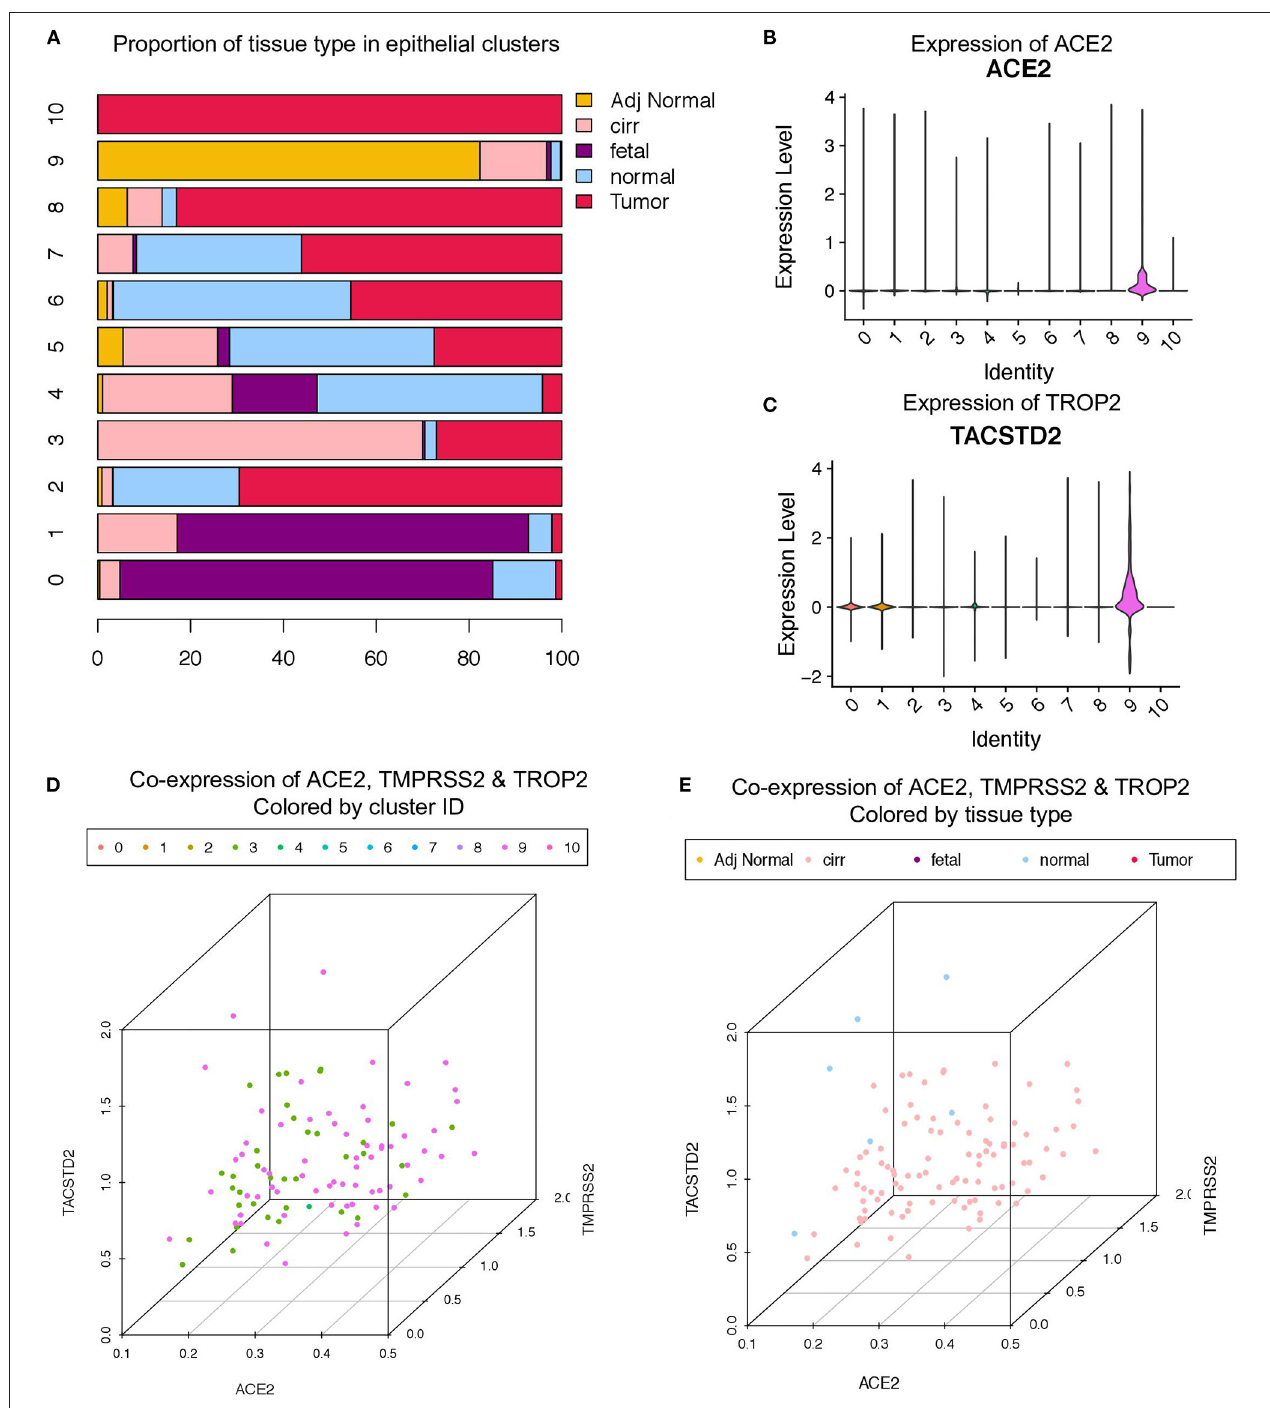
FIGURE 3 | Co-expression of ACE2, TMPRSS2, and TROP2 in liver epithelial cells. (A) Bar plot depicting the proportion of different tissue types in liver epithelial clusters. Expression of (B) ACE2 and (C) TROP2 in Louvain clusters. Three-dimensional plots of ACE2, TMPRSS2, and TROP2 co-expression (D) colored by Louvain cluster ID and (E) colored by tissue